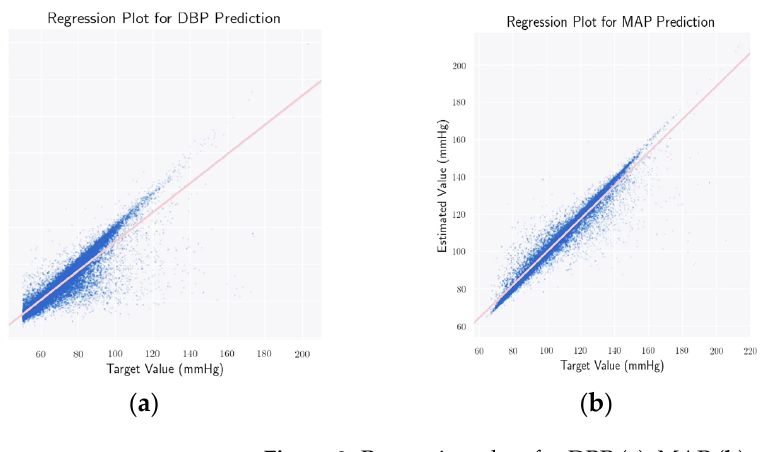
Figure 8. Regression plots for DBP ( a ), MAP ( b ), and SBP ( c ) predictions, respectively. In all three cases, we obtain a p -value in the range of p < 0.000001, which rejects the null hypothesis and strength- ens the statistical significance of our method.